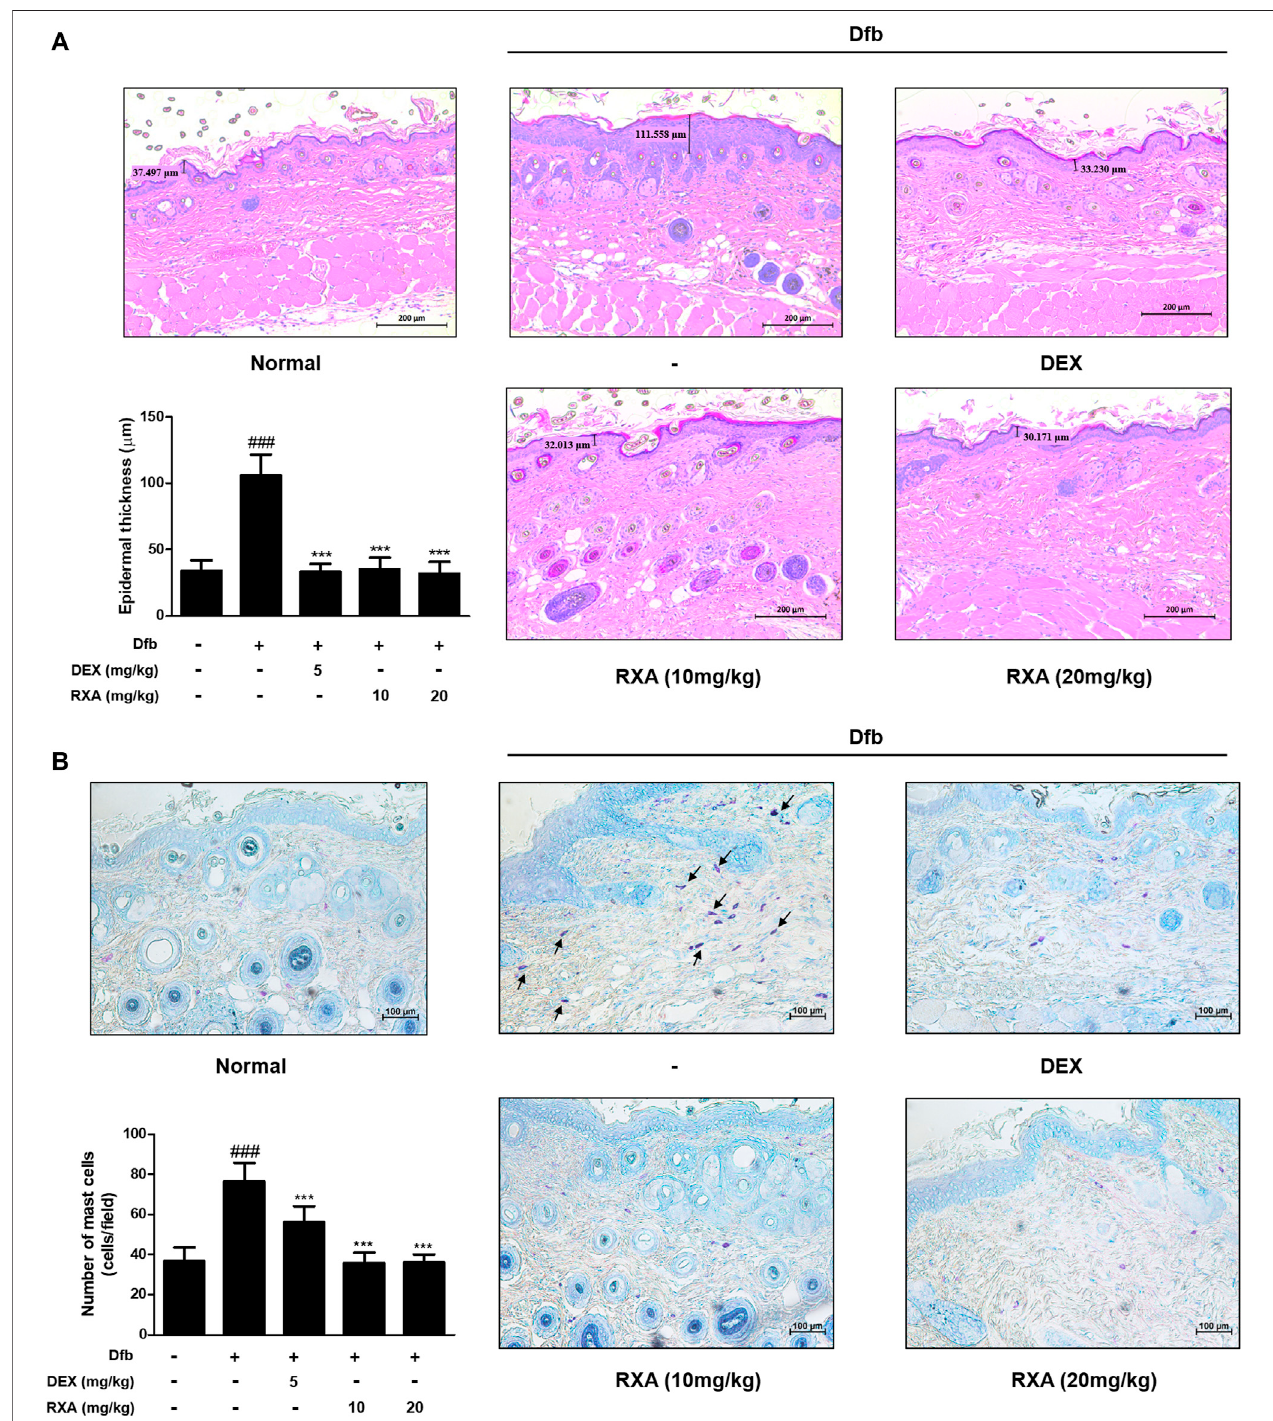
FIGURE 3 | Effects of RXA on the epidermal thickness and mast cell in fi ltration in the dorsal skin of the Dfb-induced NC/Nga mice. (A) Histological features of the dorsal of NC/Nga mice. Tissues were excised, fi xed in 10% formaldehyde, embedded in paraf fi n, and sectioned. The sections were stained with H&E (scale bar (cid:1) 200 μ m).EpidermalanddermalthicknessinH&Estainedsectionsweremeasuredunderamicroscope. (B) Thesectionswerestainedwithtoluidinebluetoidentifymast cells. Blue arrows indicate stained mast cells. Mast cells were counted with a microscope (scale bar (cid:1) 100 μ m). The data shown represent mean ± S.D. of three independent experiments ( n (cid:1) 8). ### p < 0.001 vs. the control group; *** p < 0.001 vs. Dfb-treated group. Dfb, Dermatophagoides farinae body.